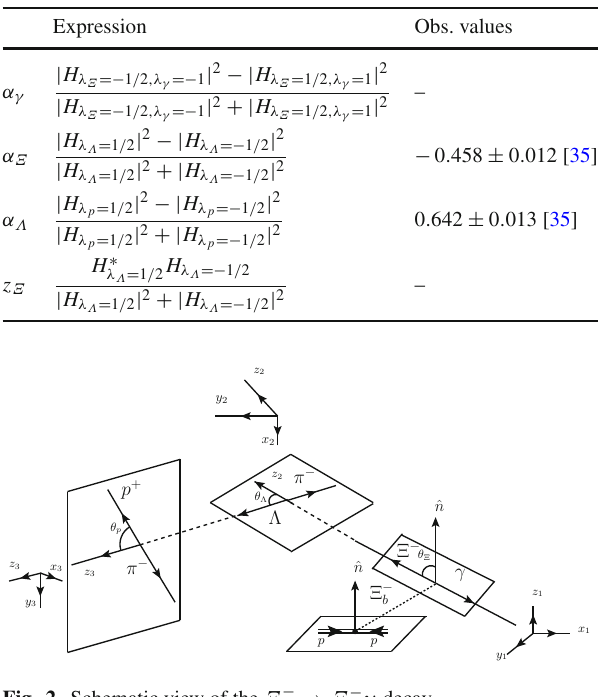
tum. A schematic view of the decay is shown in Fig. 2. The − → Ξ − γ is described by two complex primary decay Ξ b with λ Ξ = ± 1 / 2, λ γ = ± 1 helicity amplitudes H λ Ξ ,λ γ referring to the helicity values of the respective particles. To define the angles we consider three Cartesian coordinate sys- − , Ξ − and Λ 0 . In the tems attached to the rest frames of Ξ b − , the z 1 -axis is chosen to be parallel to the rest frame of Ξ b Ξ − polarization direction ˆ n . Similar to the previous case, the b relevant kinematic variables are defined as